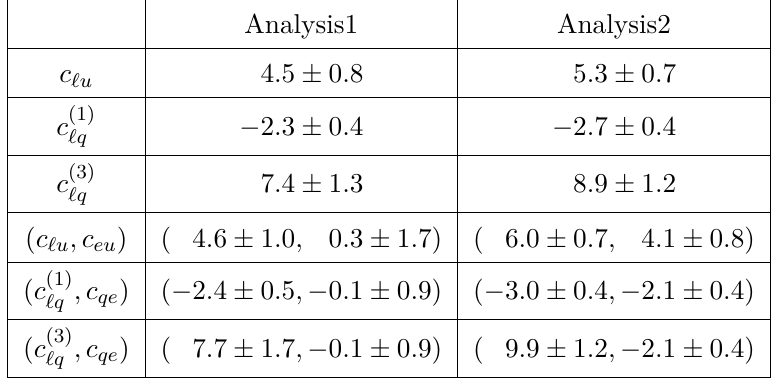
Table 1 . Values of Wilson coefficients, C i = c i / (1 TeV ) 2 , for the flavor-conserving SMEFT oper- ators, (5.5). Here, “Analysis1” is derived by recasting (5.1) and (5.2), and “Analysis2” from (5.3) and (5.4). The upper (lower) group is obtained by the 1D (2D) global fits.